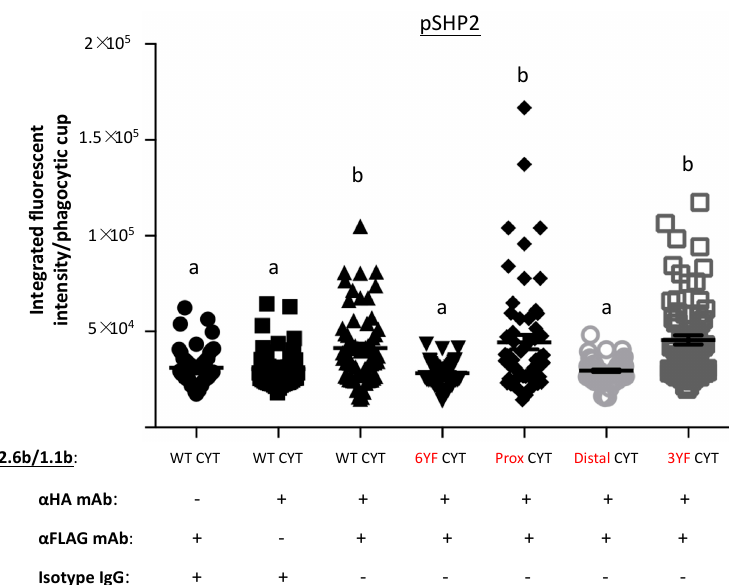
Figure 6. Confocal microscopic analysis of pSHP-2 recruitment to phagocytic cups following co-crosslinking of various IpLITR constructs. 2.6b ITAM CYT / 1.1b WT CYT co-expressing AD293 cells (2 × 10 5 ) ( A ) or AD293 cells co-expressing 2.6b ITAM CYT with various mutant 1.1b CYT constructs ( B ) were incubated at 37 ◦ C with 4.5 µ m non-fluorescent (NF) beads opsonized with the indicated mAbs and / or isotype IgG1 (’ + ’ and ‘ − ’ indicate the presence and absence of corresponding antibodies, respectively). After 8 min, cells were fixed with 4% PFA and non-phagocytosed beads were stained using Alexa 647-conjugated (red) goat- α -mouse secondary pAb. After the bead staining step, cells were permeabilized and stained for pSHP-2 by incubating with a rabbit α -pSHP-2 mAb and then a secondary goat- α -rabbit pAb conjugated to Alexa 488 (green). Representative images from z-stack acquisitions are shown with Csk (top panels; green) staining, surface-exposed bead (middle panels; red) staining and merged-fluorescence images (bottom panels). Yellow arrowheads show positions of representative phagocytic cups and the accumulation of pSHP-2 staining at locations where extracellular bead staining is absent. ( C ) Quantitative analyses of pSHP-2 staining intensities at phagocytic cups were performed using ImageJ software. At least 50 phagocytic cups from three independent experiments were analyzed and the data is represented as mean integrated fluorescent intensity ± SEM. Di ff ering letters indicate statistical significance ( p ≤ 0.05) between means. Experimental groups were compared using a one-way ANOVA, followed by the Tukey test using Prism 6 software (GraphPad Software, La Jolla, CA, USA).